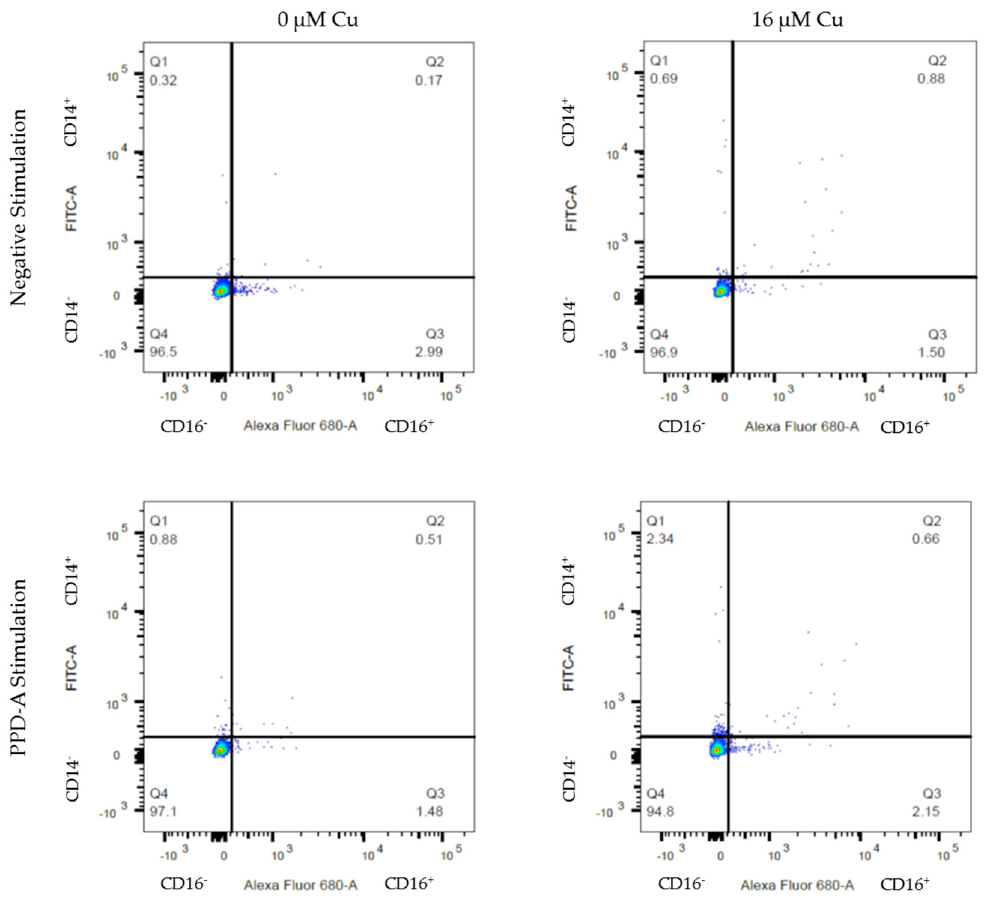
Figure 3. Representative flow cytometry graphs of PBMCs of a six year old cow in FlowJo software. Percentage CD14 (FITC) and CD16 (Al680) expression was determined for live cells in the presence of increasing copper (0 and 16 µ M) and exposed to different stimulations (media alone and PPD-A) for 24 h.